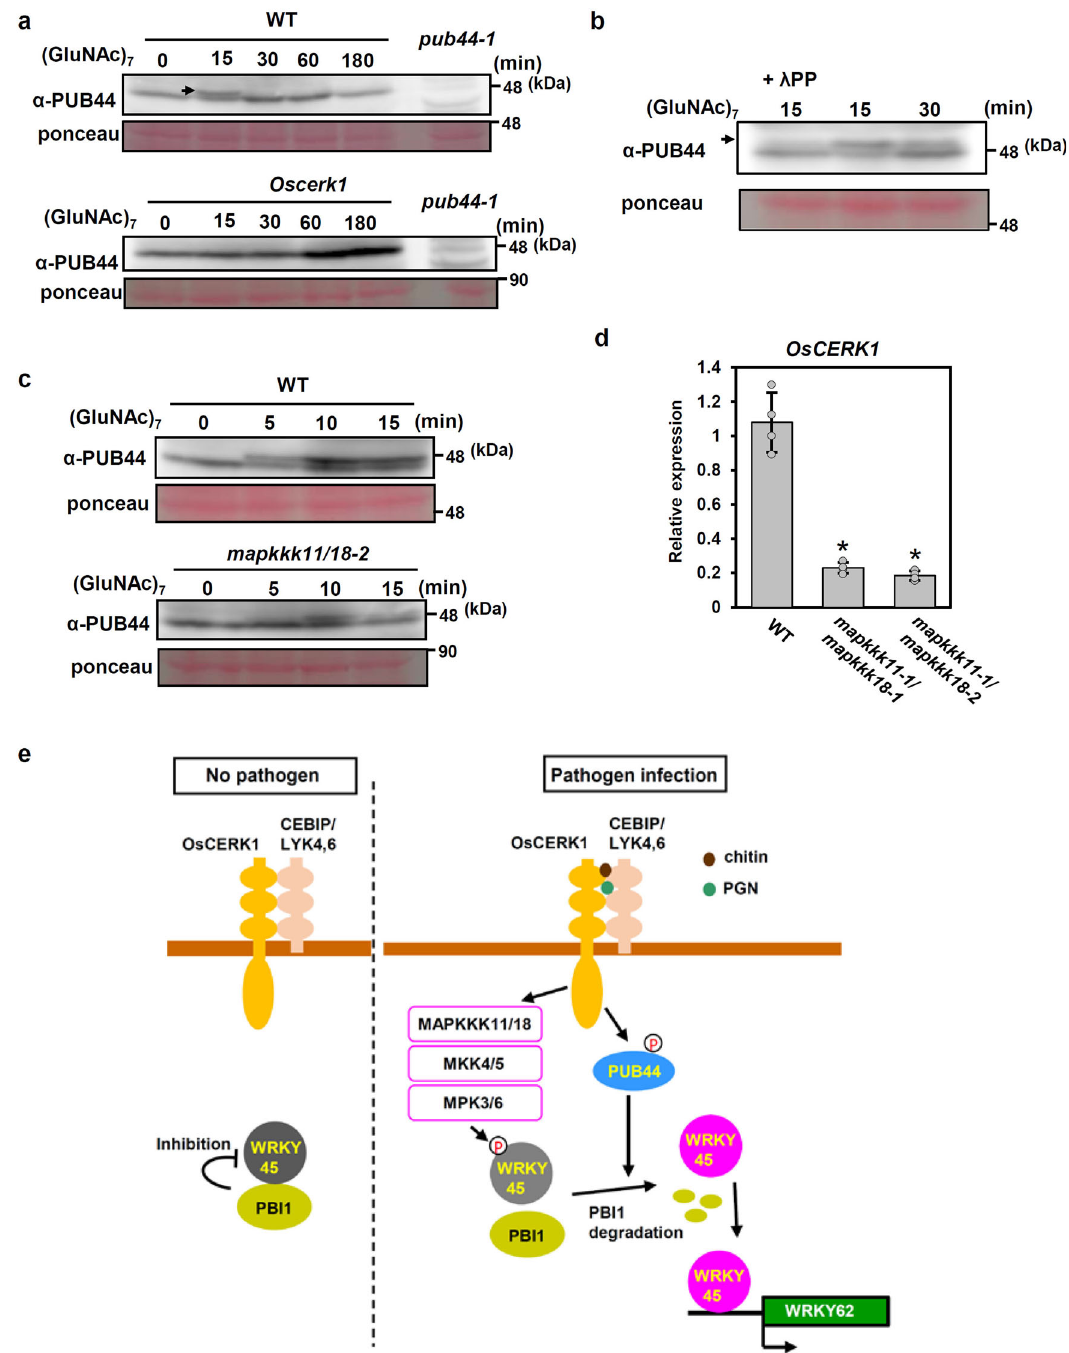
Fig. 7 PUB44 is phosphorylated upon chitin perception. a A mobility shift of PUB44 was detected by immunoblotting with α -PUB44 using total proteins prepared from WT rice suspension-cultured cells after treatment with 2 μ g/ml (GluNAc) 7 (upper panel). The arrow indicates the shifted PUB44 band. The mobility shift did not occur in Oscerk1 mutant cells (lower panel). b The mobility shift of PUB44 was reversed by treatment with λ protein phosphatase, indicating that the shift was due to phosphorylation of PUB44. The arrow indicates the shifted PUB44 band. c PUB44 phosphorylation was delayed and reduced in the mapkkk11/18 mutant (lower panel) when compared with WT cells (upper panel). d OsCERK1 transcript levels in WT and mapkkk11/18 mutant cells, measured by quantitative real-time PCR. Data are means ± SD. n = 4 biologically independent replicates. The asterisks indicate statistically signi fi cant differences from the WT control by two-sided Student ’ s t -test ( P < 0.05). e Proposed model of WRKY45 activation. Under unelicited conditions, PBI1 inhibits WRKY45 activation in order to maintain its basal activity. Upon perception of chitin / PGN, the MAPK cascade is activated and MAPKs phosphorylate WRKY45, which reduces the binding af fi nity between WRKY45 and PBI1. At the same time, PUB44 is phosphorylated in OsCERK1- dependent manner, and then PBI1 is degraded. The phosphorylation of WRKY45 by MAPKs and the PBI1 degradation fully activate WRKY45. Experiments in ( a – d ) were performed three times with similar